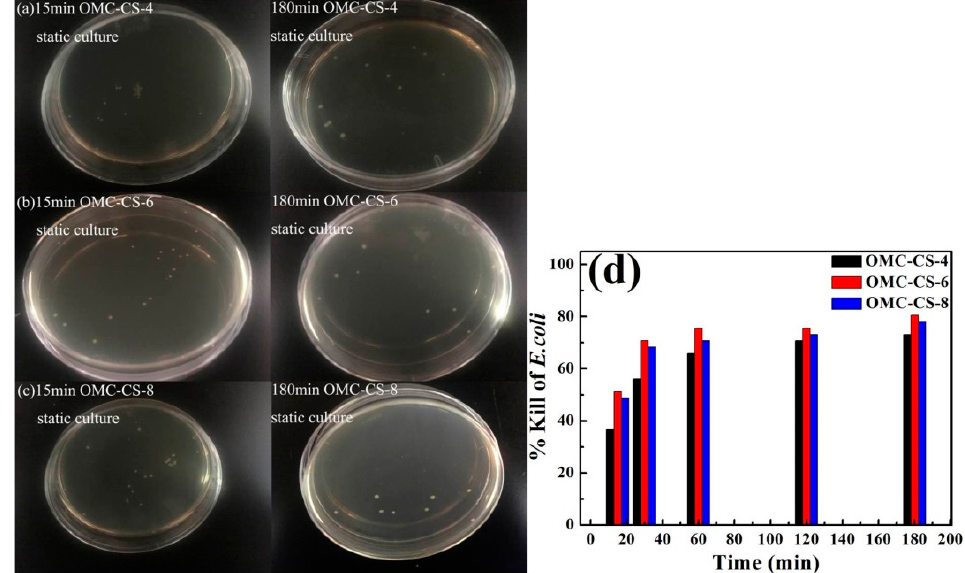
Figure 10. ( a–c ) The colony forming units; ( d ) Killing rate of microbes; after CDI static culture